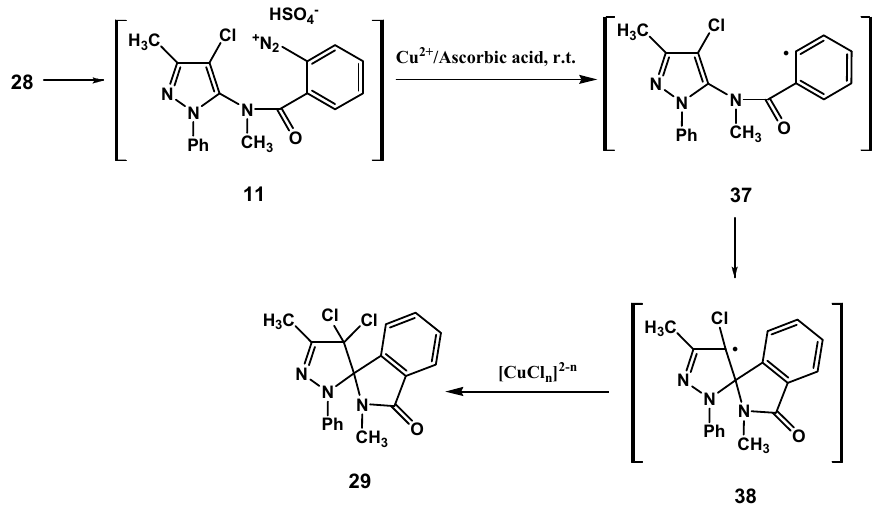
Scheme 6. Suggested mechanism for the transformation of 11